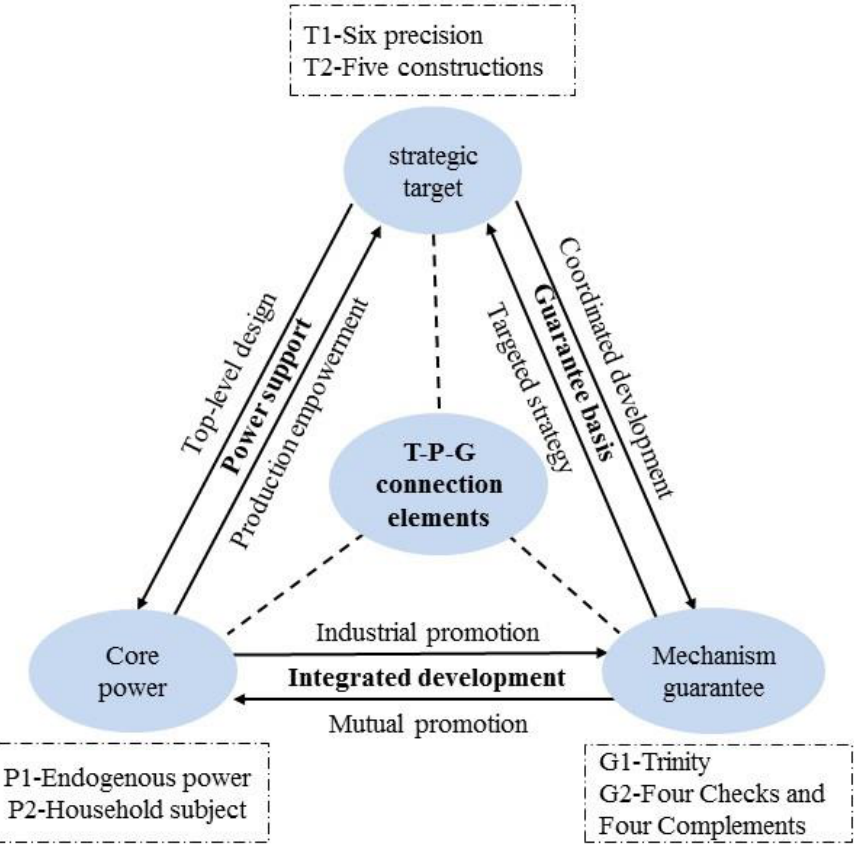
Figure 2. The internal logic of effective connection between poverty alleviation and rural revitalization.